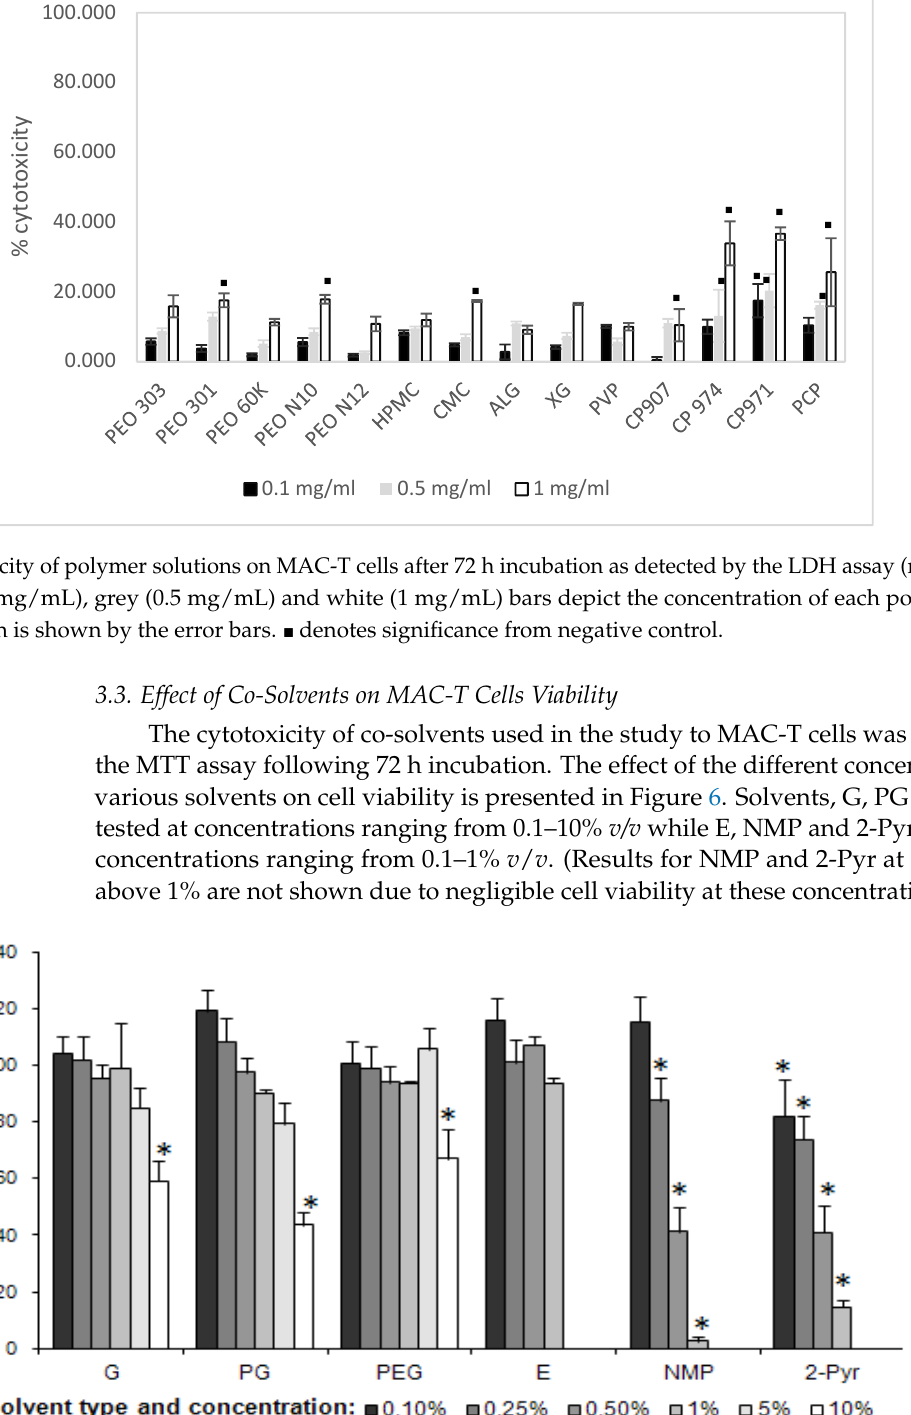
Figure 6. MAC-T cell viability in various concentrations of different solvents after 72 h. Black, various grades of grey and white bars depict the concentration of each solvent ranging from 0.1, 0.25, 0.5, 1, 5 and 10%. Cell viability was detected by MTT assay and expressed as a percentage of viability of untreated control cells (mean ± SD, n = 3). The standard deviation is shown by the error bars. * denotes significance from negative control. (Legend: glycerin (G), propylene glycol (PG), polyethylene glycol 400 (PEG), ethanol (E), N-methyl-2-pyrrolidone (NMP) and 2-pyrrolidone (2-Pyr).